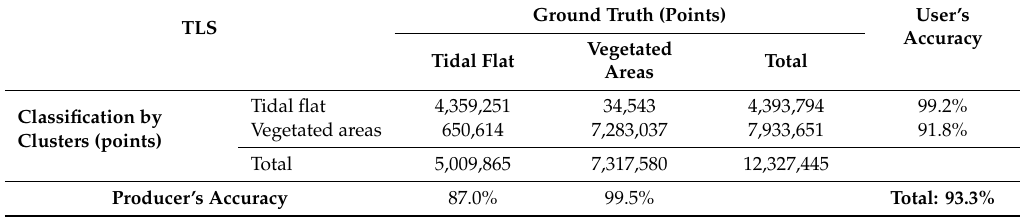
Table 4. Summary of the quantitative assessments of TLS segmentation results for 7 clusters in identifying tidal flats and areas covered by vegetation.